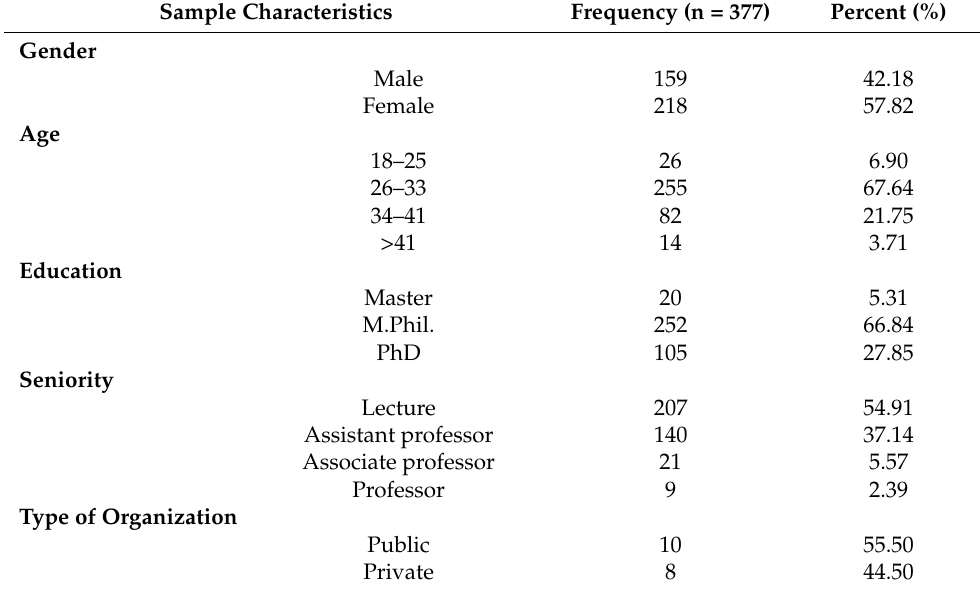
Table 1. Demographic